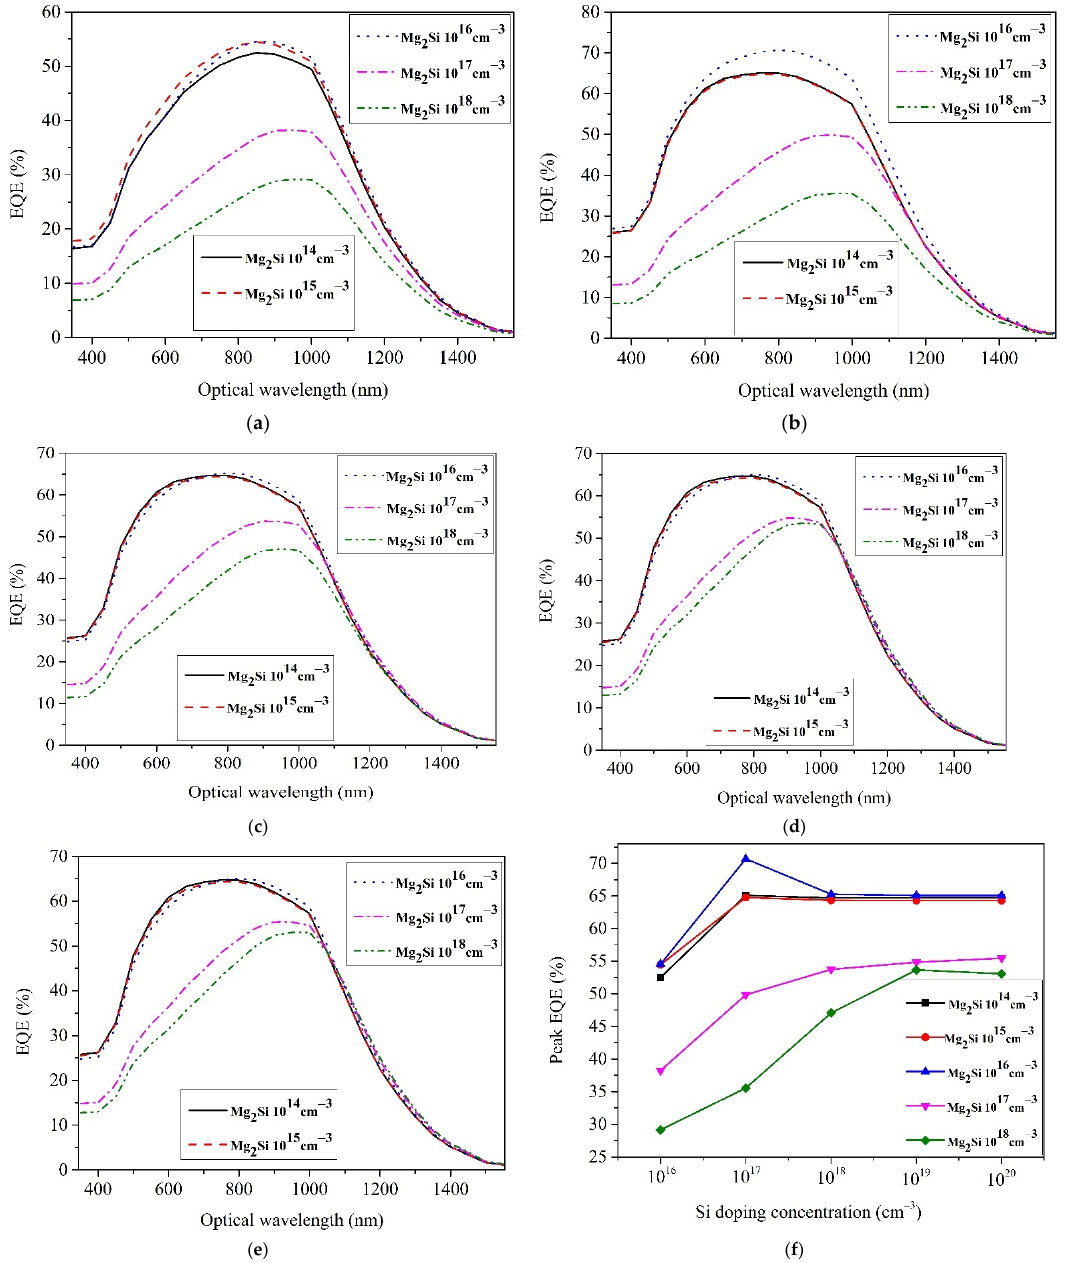
Figure 7. EQE curves of the heterojunction PDs with different doping concentrations. ( a ) Si–10 16 cm − 3 . ( b ) Si–10 17 cm − 3 . ( c ) Si–10 18 cm − 3 . ( d ) Si–10 19 cm − 3 . ( e ) Si–10 20 cm − 3 . ( f ) The effect of doping concentrations on EQE. The NEP is defined as follows [29,30]: